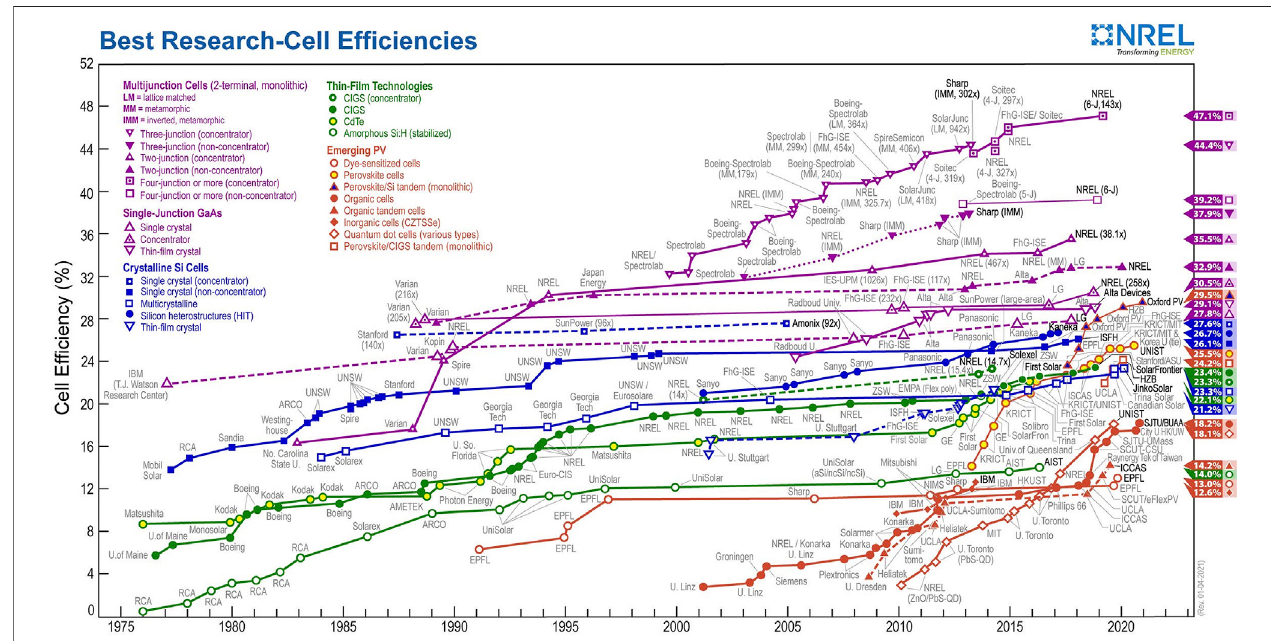
FIGURE 4 | The ef fi ciency of record-performance solar cells in each of the primary technologies. Amorphous Si (a-Si) and the single-crystal concentrator cells are triple junctions in the most recent devices whilst the others are single junctions. CIGS indicates the alloy Cu(In1 − xGax)Se2 (Photovoltaic Research | NREL).